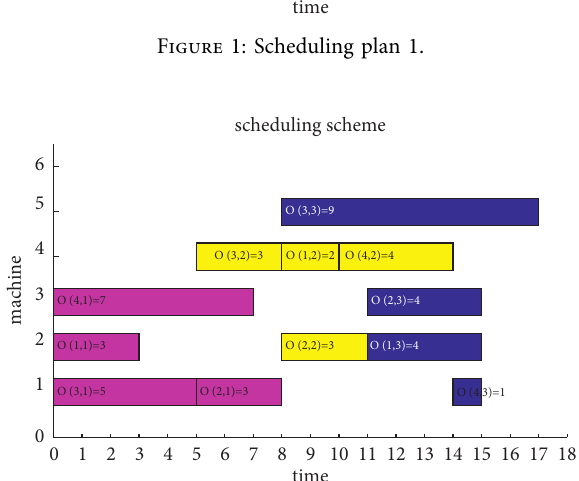
Figure 1: Scheduling plan 1.